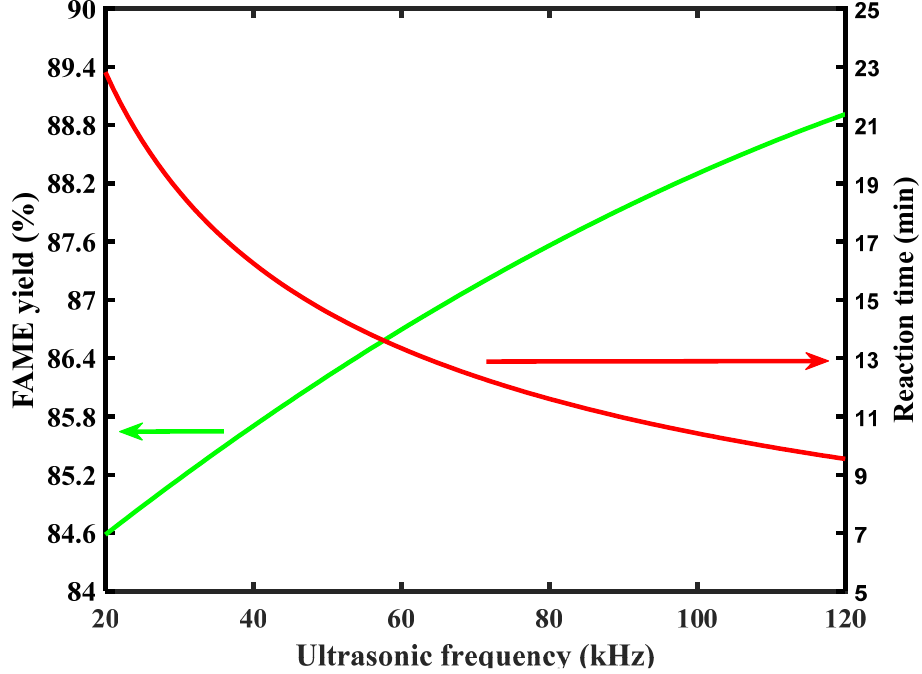
Figure 13. The effect of frequency on the reaction yield for the membrane system.